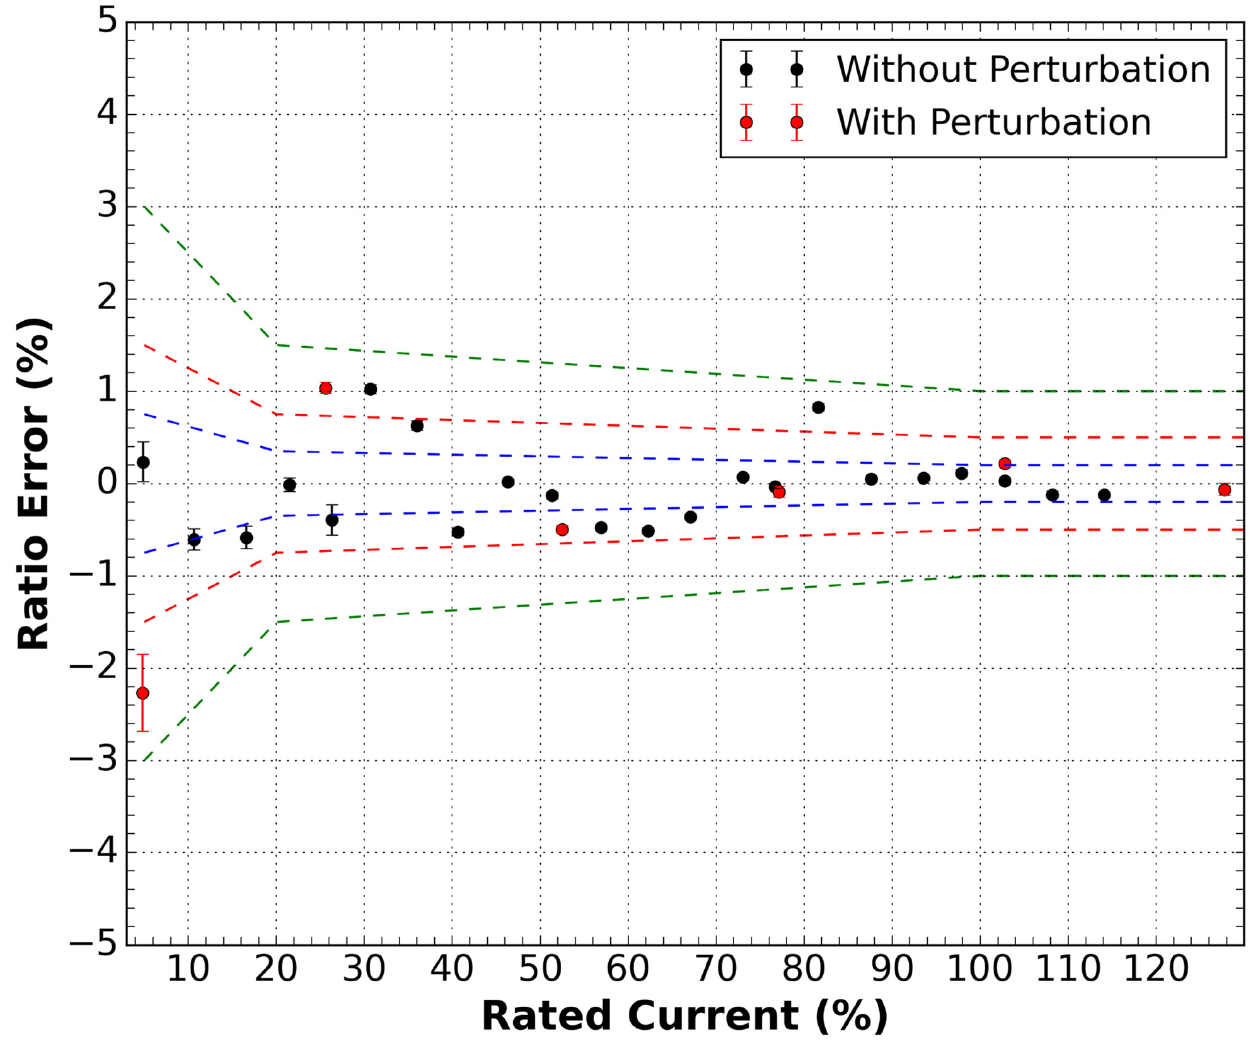
Figure 5. Ratio error measurements as a function of the rated current for the sensor outside the DWDM network. Two conditions were measured, with and without disturbance in the optical cable of the sensor. Green dashed lines are the 1.0 class limits, red dashed lines are the 0.5 class limits, and the blue dashed lines are the 0.2 class limits.